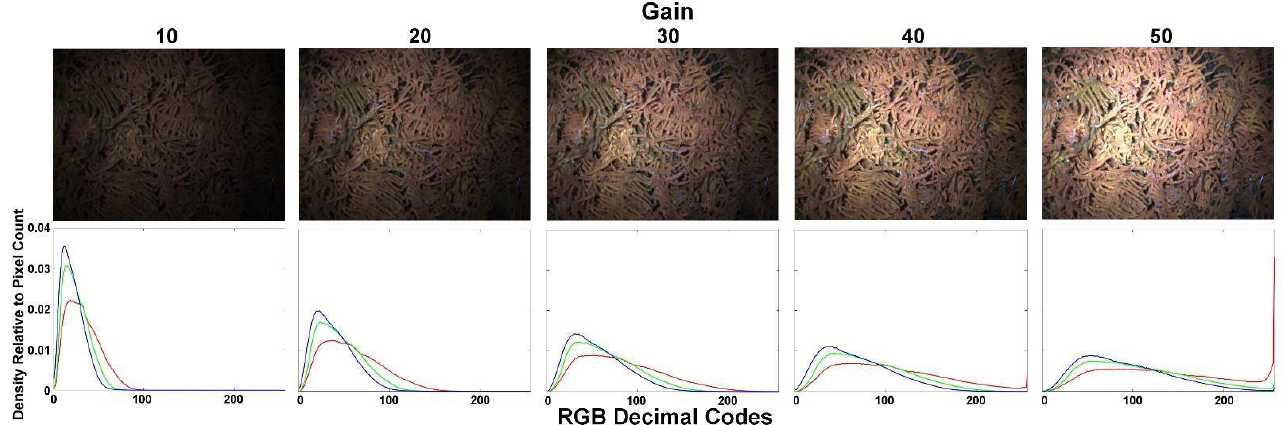
Figure 4. Color histogram: number of pixels corresponding to each red, green, and blue level of intensity scaled by the total number of pixels. Top row shows images at 5 gain levels collected from the day-0 control sample using both lasers. The bottom row shows the corresponding density histogram profiles of each RGB decimal code value found in each pixel of the images. Here, (255, 0, 0) is the decimal code for red, (0, 255, 0) is the decimal code for green, and (0, 0, 255) is the decimal code for blue. Code (0, 0, 0) would be absolute black and (255, 255, 255) absolute white.